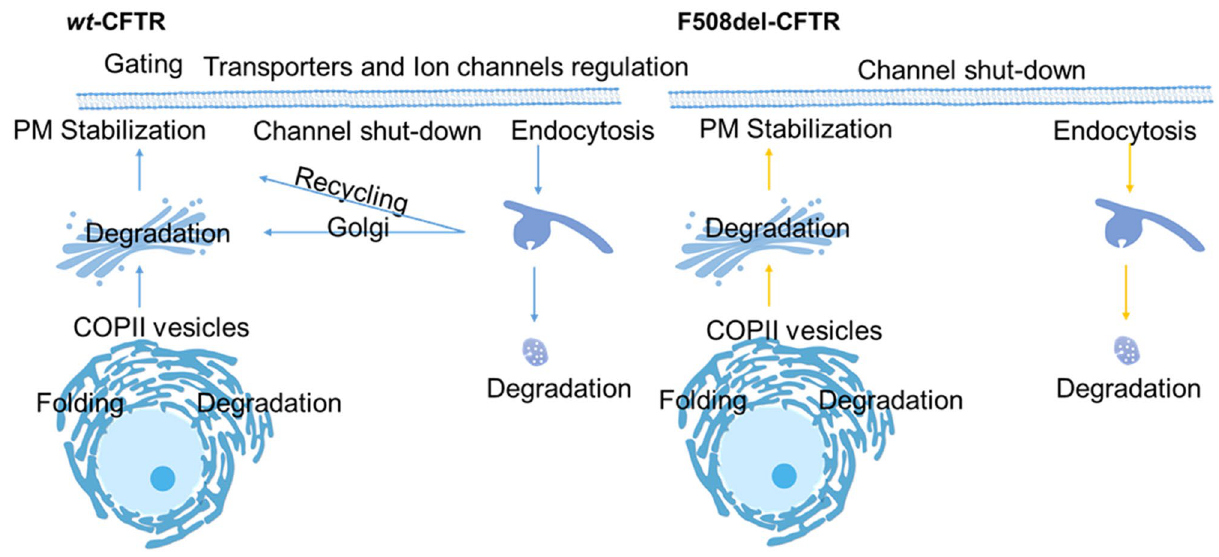
Figure 1. Modules available in the CyFi-MAP. wt- CFTR (left) and F508del- CFTR (right) modules include the key processes available included in the CyFi-MAP and provide a way to focus on a specific part of CFTR life cycle. Rescued F508del- CFTR (rF508del-CFTR) pathways are highlighted in yellow, indicating the processes elicited after chemical or temperature rescue of the mutant protein (see text for